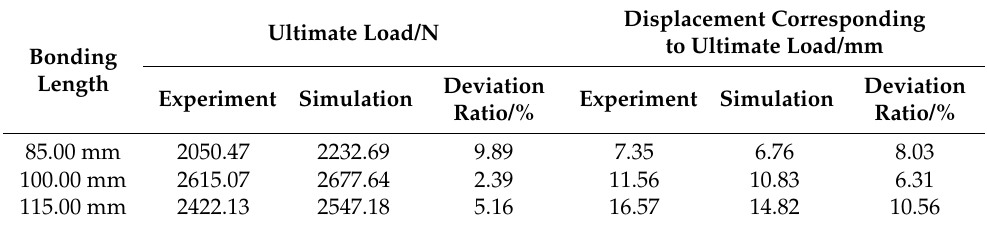
Table 4. The comparison of the ultimate loads and corresponding displacements of different L-joint experiments and simulation curves.